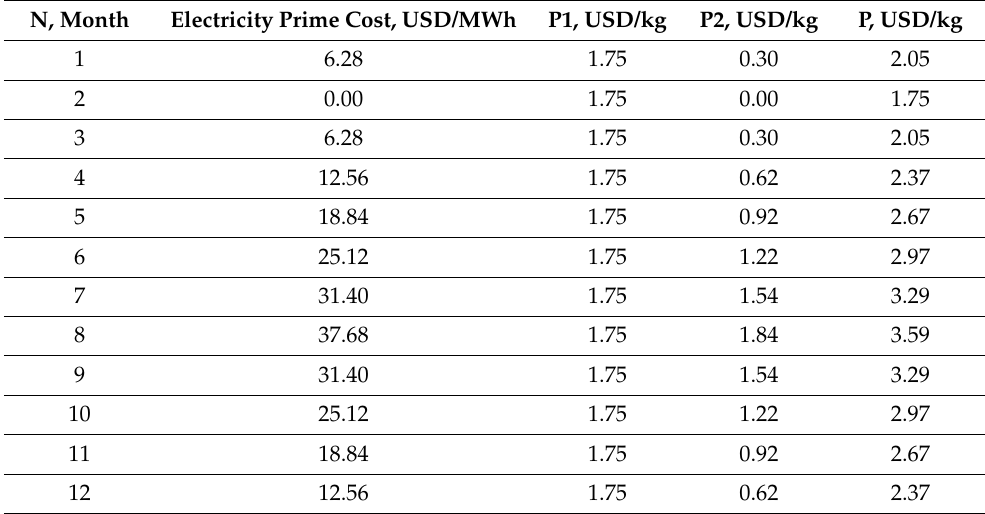
Table 9. Structure of the cost of hydrogen production depending on the cost of electricity. N,